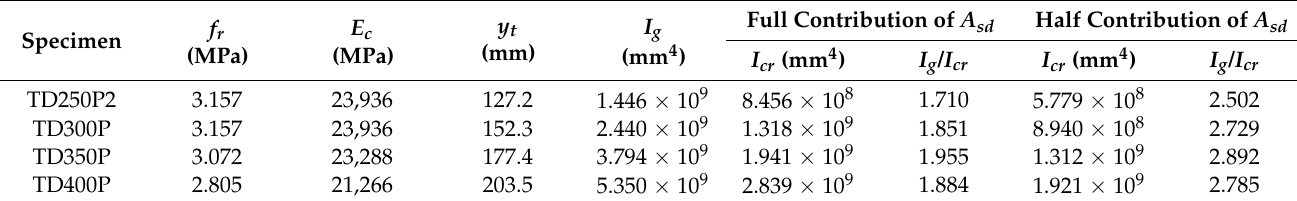
Table 4. Values of parameters used to calculate immediate deflection (TD